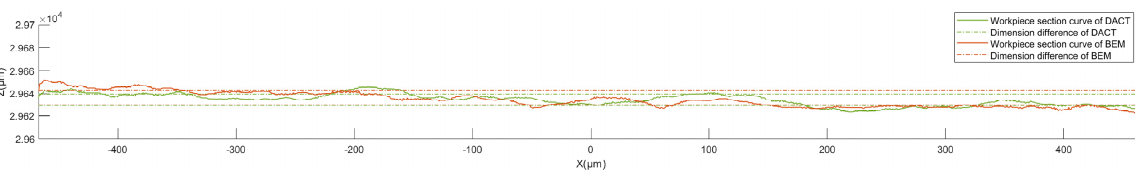
Figure 20. Workpiece surface topography machined by BEM.